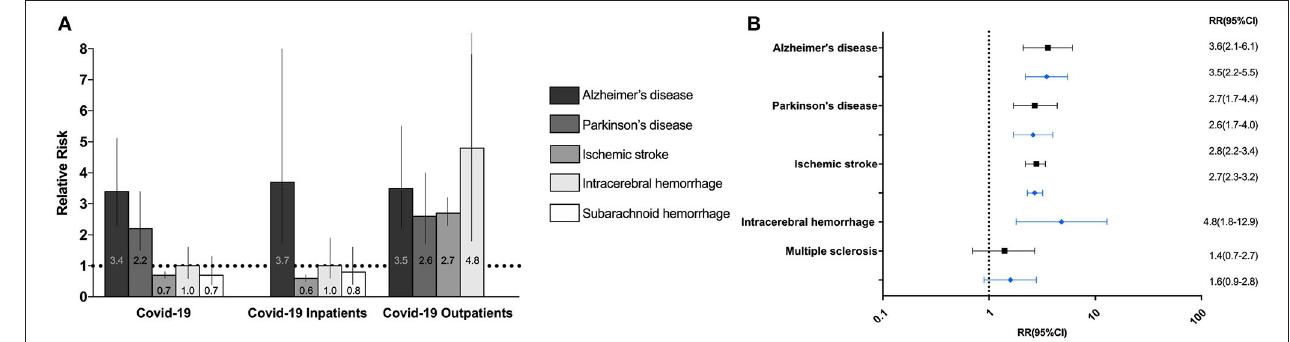
FIGURE 2 | Relative risk of neurodegenerative, cerebrovascular and neuroimmune neurological disorders after COVID-19 (A) . Bar chart of the relative risks (RR) of new-onset neurodegenerative disorders and cerebrovascular events after 12 months in COVID-19 positive versus COVID-negative individuals, inpatients, and outpatients. Barcharts depict RR with 95% confidence intervals. (B) Forest plot of the RR of new-onset neurodegenerative, cerebrovascular and neuroimmune disorders six (black) and twelve (blue) after COVID-19 in COVID-19 positive outpatients compared to negative